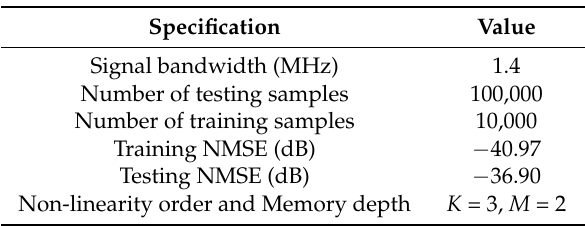
Table 6. Summary of the performance evaluation of the analog combining, mixer-less three-way amplitude modulator-based